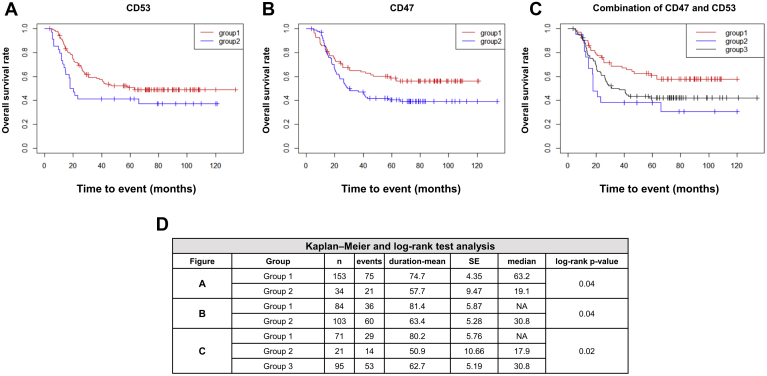
Survival analysis of the selected biomarkers from patients with AML based on The Cancer Genome Atlas data. A, Kaplan–Meier survival curves showed the correlation between the survival and mRNA expression data of CD53 and CD47 at initial diagnosis based on TCGA data of 187 patients with AML. The patients were divided into two groups according to an effective cut-off value. If the CD53 or CD47 expression was lower than the cut-off value, patients were classified into group 1. If not, they were classified into group 2. In case of CD53, group 2 showed decreased survival probability with borderline significance relative to group 1. B, in the case of CD47, the survival probability of group 2 was significantly lower than that of group 1. C next, we analyzed the survival probability by combining two markers and reclassifying patients into three groups. Group 1 was composed of patients with AML referred to group 1 with regard to both markers. Group 2 was composed of patients with AML referred to group 2 with regard to both markers. Patients with AML not belonging to group 1 or 2 were classified into group 3. Group 2 showed the lowest survival probability relative to group 1 or group 3. D, Kaplan–Meier survival analysis with log-rank test for overall survival of patients with AML according to CD53 and CD47 is shown in Table 3. AML, acute myeloid leukemia; TCGA, The Cancer Genome Atlas.